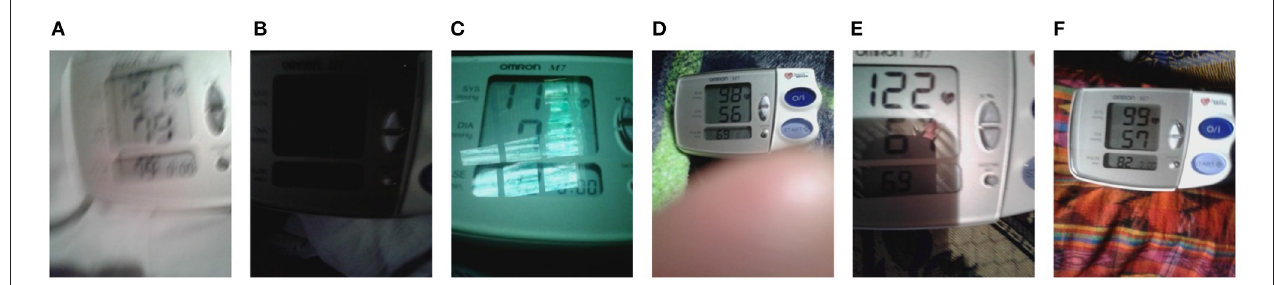
FIGURE 4 | Examples of each class from blood pressure images dataset: (A) Blur. (B) Dark. (C) Contains reflections. (D) Far. (E) Cropped. (F) Good quality.